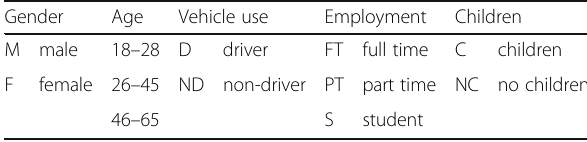
Table 3 Coding for individual identifiers Gender